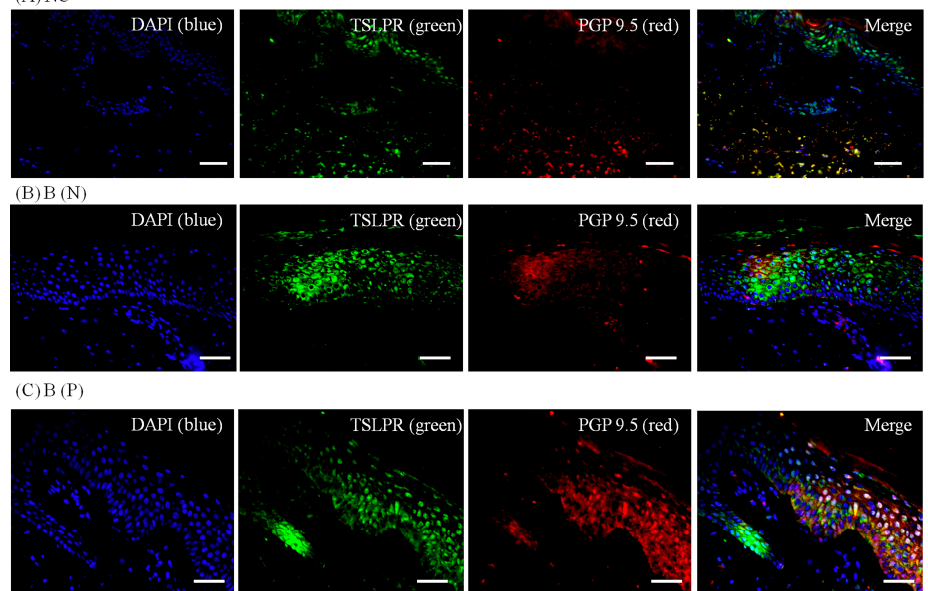
Figure 8. Three-color immuno fl uorescence confocal images were obtained for DAPI ( blue ), TSLPR ( green ) and PGP 9.5 ( red ) from tissues of ( A ) Normal, ( B ) Nonpruritic and ( C ) Pruritic burn scars. The staining of TSLPR, mainly observed in the lower spinous layer and basal layer of the epidermis, was least in ( A ) Normal control and greater in ( B , C ) Burn-scar tissues with or without pruritus. NC: keratinocytes from normal control; B (N): keratinocytes from nonpruritic burn scar; B (P): keratinocytes from pruritic burn scar; TSLPR: thymic stromal lymphopoietin receptor. Scale bars = 50 μ m.